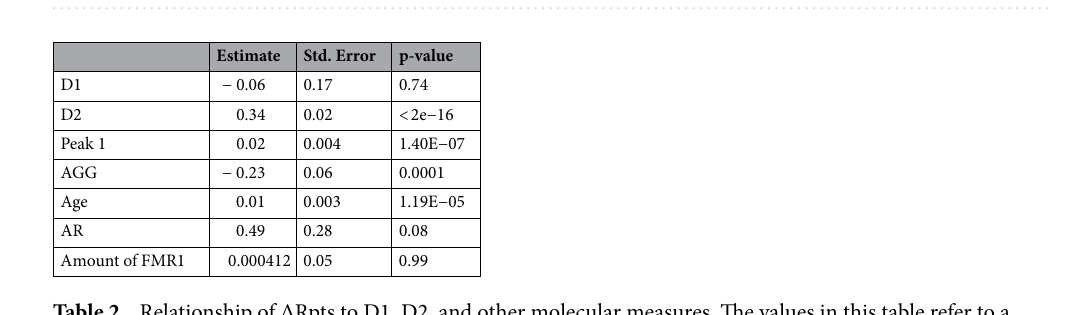
Table 2. Relationship of ∆Rpts to D1, D2, and other molecular measures. The values in this table refer to a multivariable negative binomial regression of ∆Rpts on all of the molecular measures simultaneously.